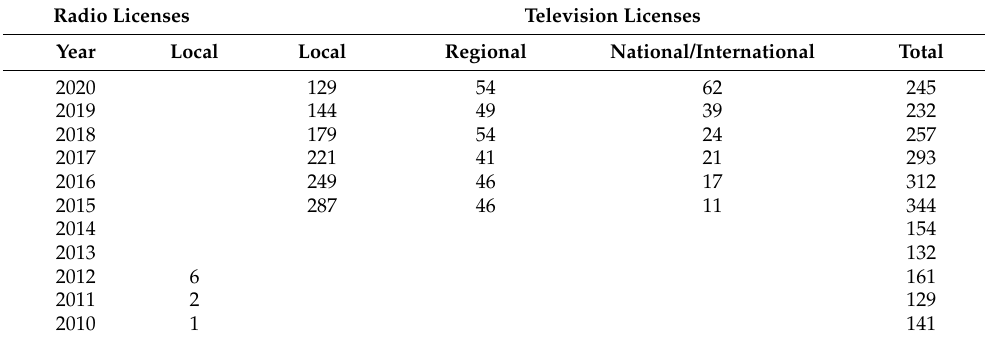
Table 3. Licenses granted for broadcasting through other electronic communications networks.